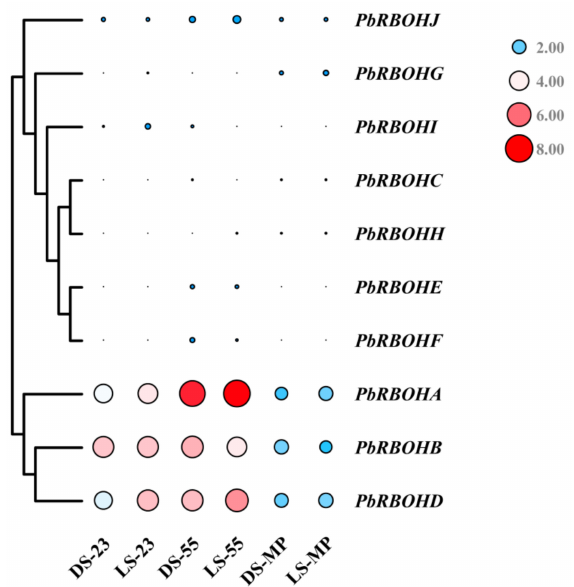
Figure 10. Expression profiles of PbRBOH s in di ff erent pear varieties at di ff erent developmental stages. FPKM values were obtained by RNA-seq analysis and presented as a heatmap. The colour scale and circle size are provided with the heat map to indicate the di ff erential pattern of expression. DS: Pyrus bretschneideri cv. Dangshan Su; LS: Pyrus bretschneideri cv. Lianglizaosu; 23: 23 DAF; 55: 55 DAF; MP: mature period. The heatmap is drawn using the TBTools v. 0.6644 software (http: // www.tbtools.com /